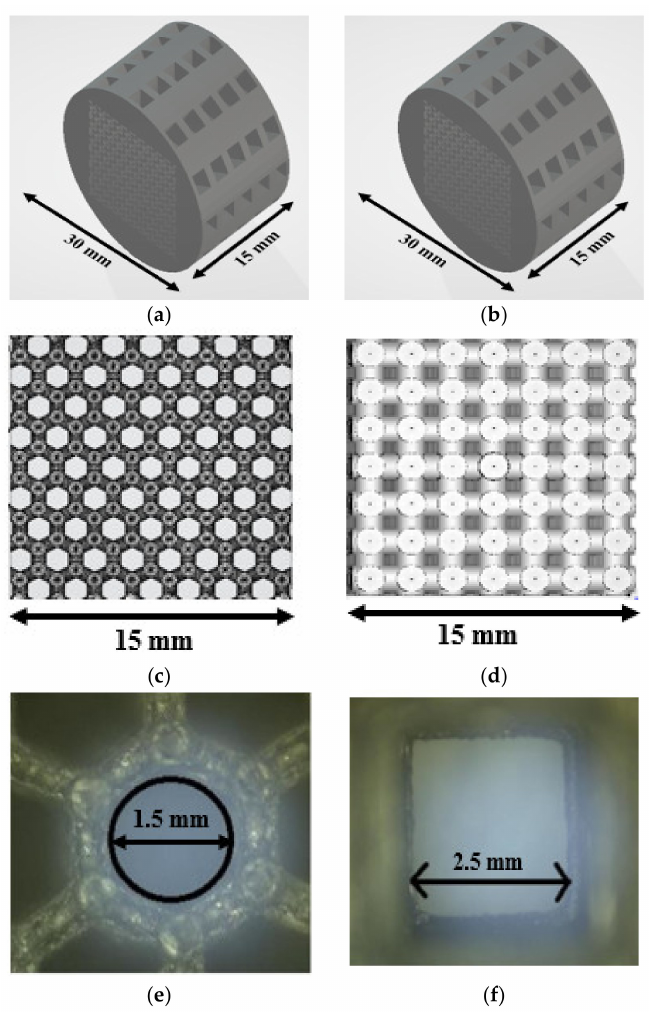
Figure 1. The 3D CAD models of the scaffold structures with hexagonal (H) and cubic (C) pore geometries: ( a ) isometric view and ( c ) front view of scaffold structure with hexagonal pore shape; ( e ) optical microscopic image of a 3D-printed scaffold with hexagonal pore shape; ( b ) isometric view and ( d ) front view of scaffold structure with cubic pore shape; ( f ) optical microscopic image of a 3D-printed scaffold pore of scaffold structure with cubic pore